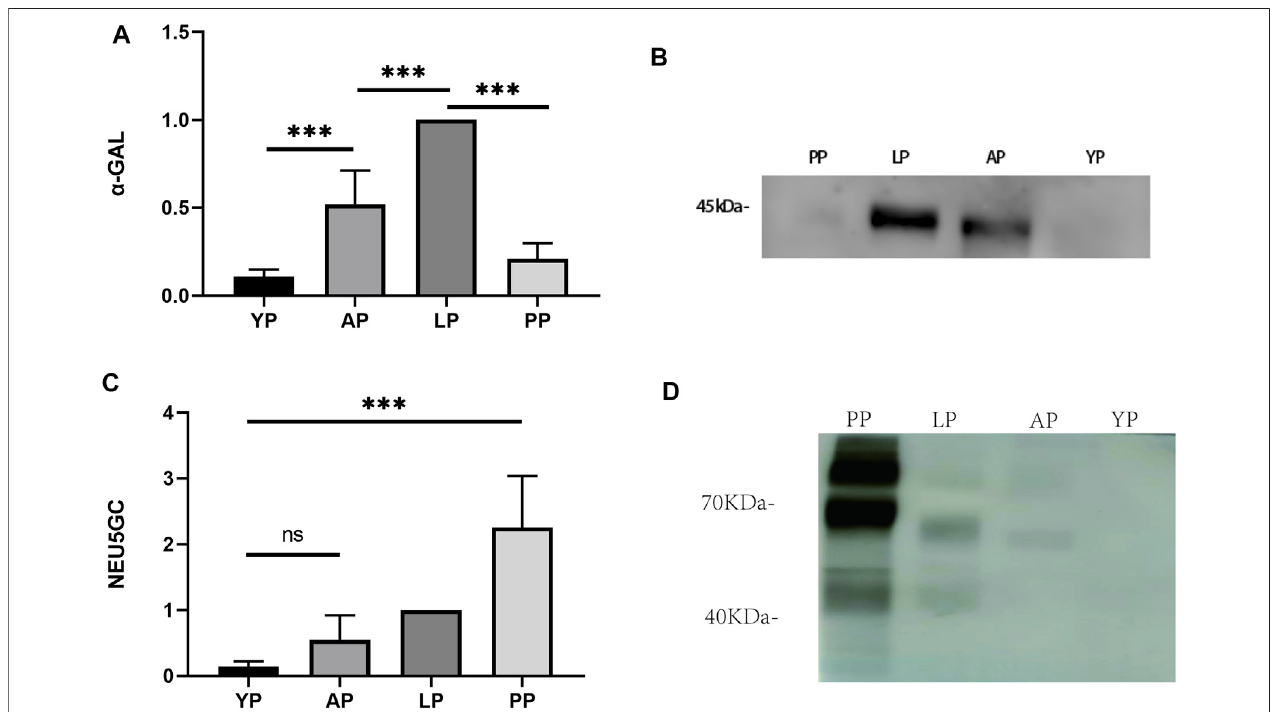
FIGURE8| Western-blot todetect transplantation-associated antigens offour different groups offresh pericardium. Quantitative comparative analysis of α -gal (A) and NEU5GC (C) ; (B, D) show that the expression of α -gal and NEU5GC of YP is the least among the four groups of pericardium. ( n (cid:2) 3; * p < 0.05; ** p < 0.01;*** p < 0.001; ns represents no signi fi cant difference).